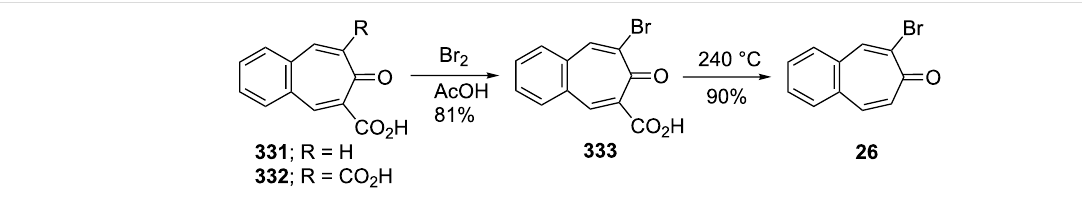
Scheme 56: Oxidation reactions of 8-bromo-5 H -benzo[7]annulene ( 329 ) with some oxidants.